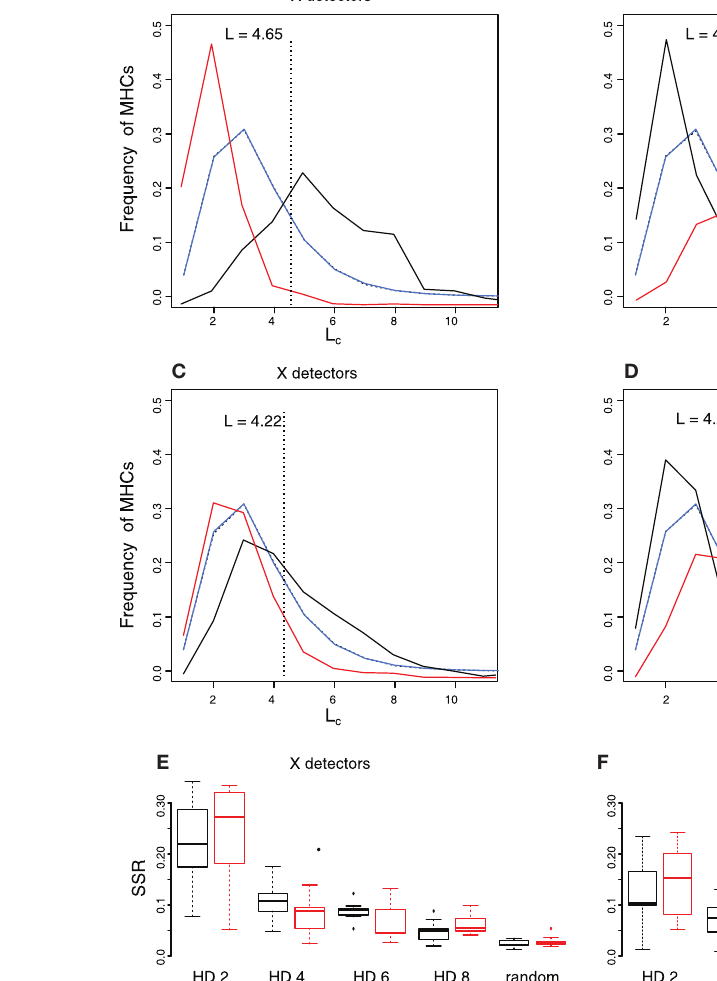
determined by measuring the L c of the evolved MHC-X detectors (A,C) and MHC-Y detectors (B,D) to the MHC-X and MHC-Y molecules in their own populations, and averaging over 10 simulations. (A–B) show simulations considering similar MHC molecules (i.e., HD = 2), and (C–D) show simulations with less similar MHC molecules (i.e., HD = 6). The sum of squared residuals (SSR) from the observed complementarity distributions to the expected L c distribution is summarized for X detectors (E) and Y detectors (F) for all 10 simulations performed per setting. The boxes represent the interquartile range and the bold horizontal lines represent the median taken out of 10